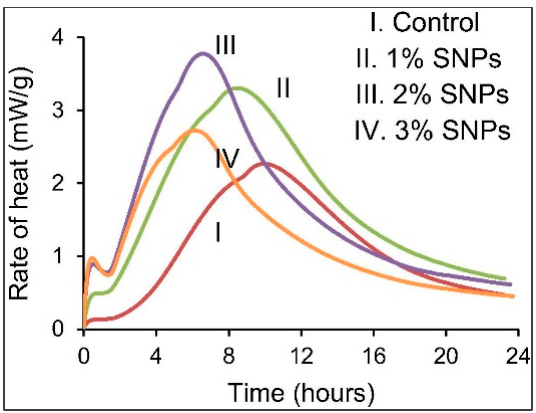
Figure 3. Effect of NS contents variation on hydration rate of OPC binders [47].